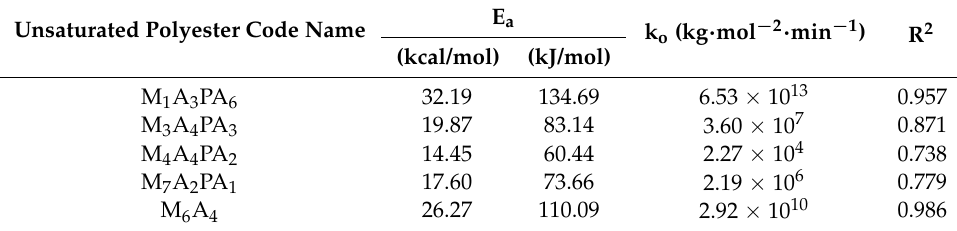
Table 3. Kinetic parameters of each laboratory synthesized unsaturated